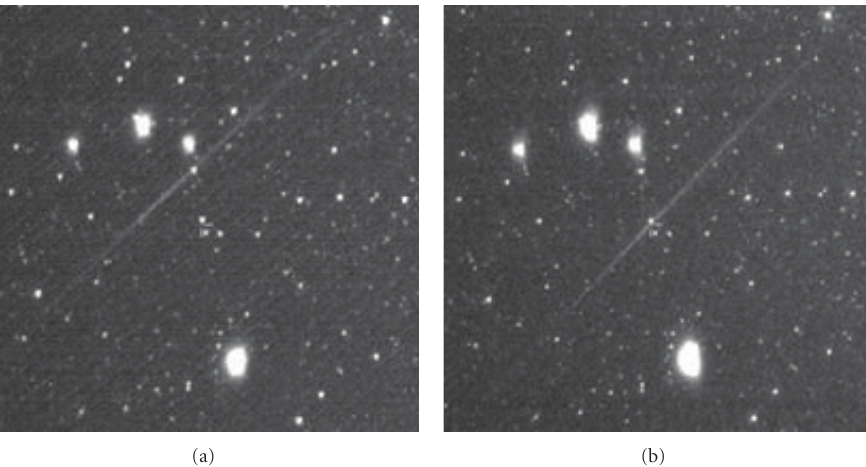
Figure 9: MASTER-VWF4 frames of a 5 ◦ × 5 ◦ sky area taken with the Northern and Southern cameras. The parallax of the meteor is immediately apparent. Triangulation yields a height of H meteor = 72 ± of 2km.